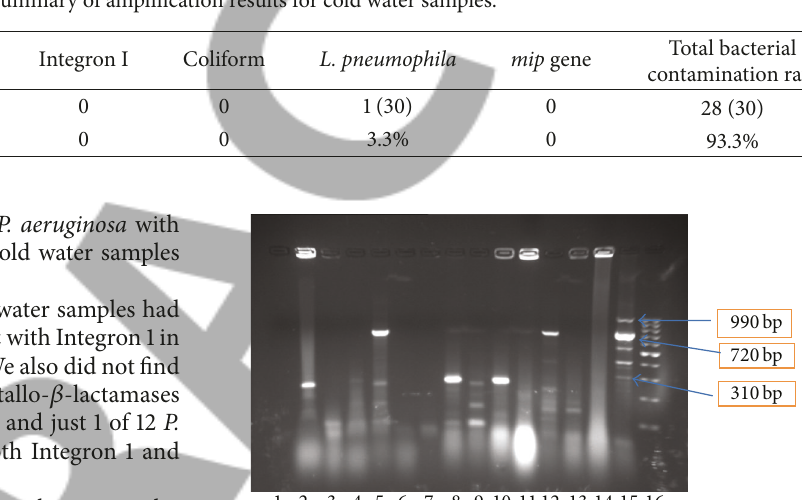
Table 2: Summary of amplification results for cold water samples.